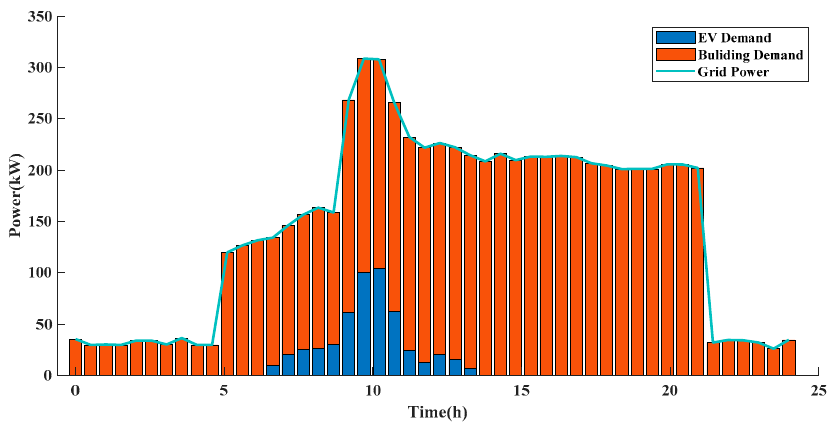
Figure 7. Initial EV charging